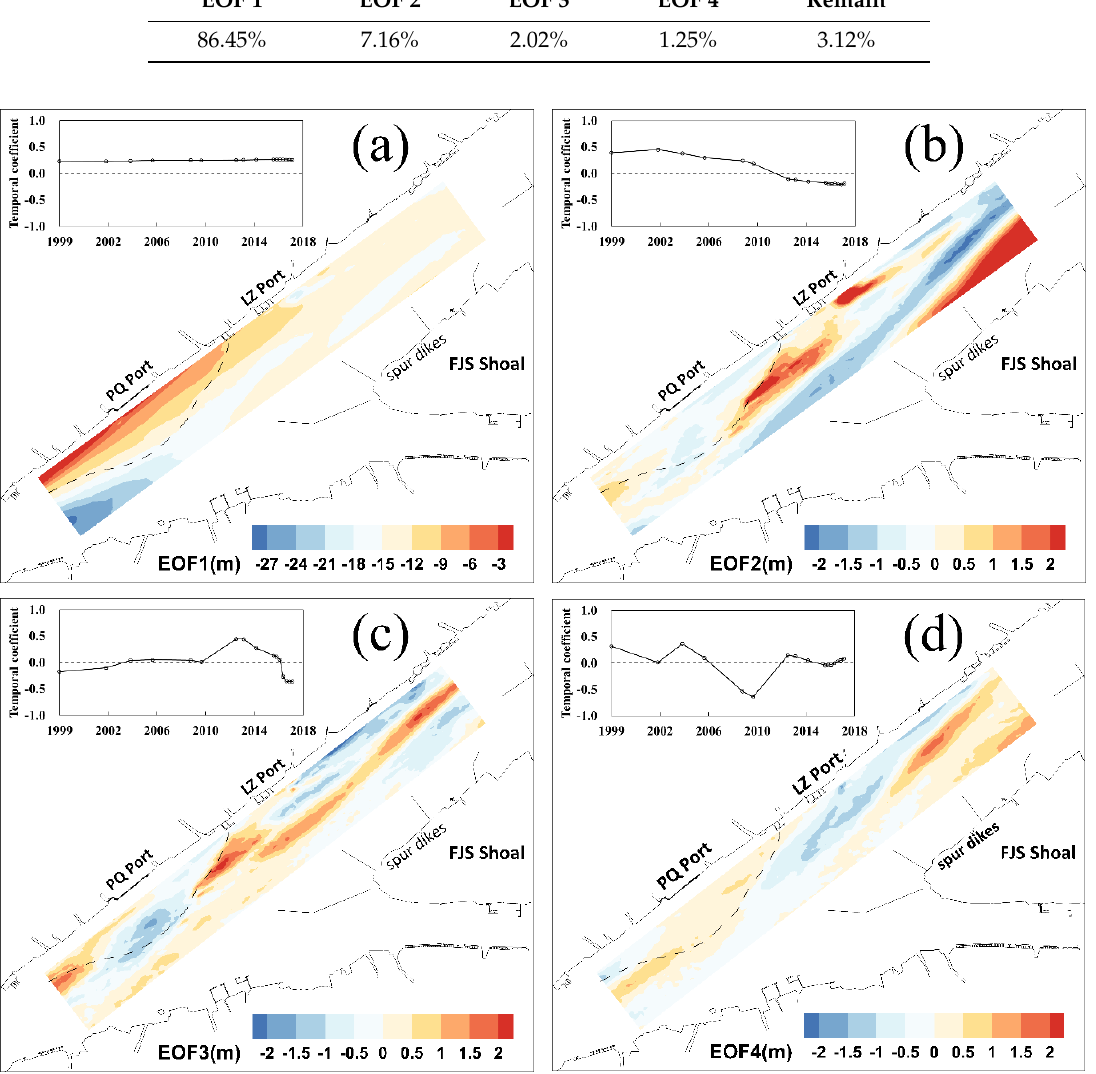
Figure 8. First four eigenfunctions (spatial modes) and the corresponding temporal coefficients in the upper left corner. The dotted line indicates the approximate area of the JJS. The color indicates the values of the corresponding eigenfunctions, which is the same size of the EOF analysis area, the unit is meter, which is the same as the analyzed data, i.e., the bathymetry. ( a ) the first eigenfunction and the corresponding temporal coefficient; ( b ) the second eigenfunction and the corresponding temporal coefficient; ( c ) the third eigenfunction and the corresponding temporal coefficient; ( d ) the fouth eigenfunction and the corresponding temporal coefficient.